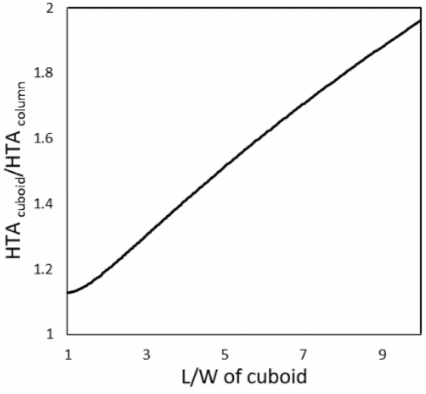
Figure 7. (HTA cuboid /HTA column ) ratio as function of the (L/W) ratio of a cuboid packed-bed